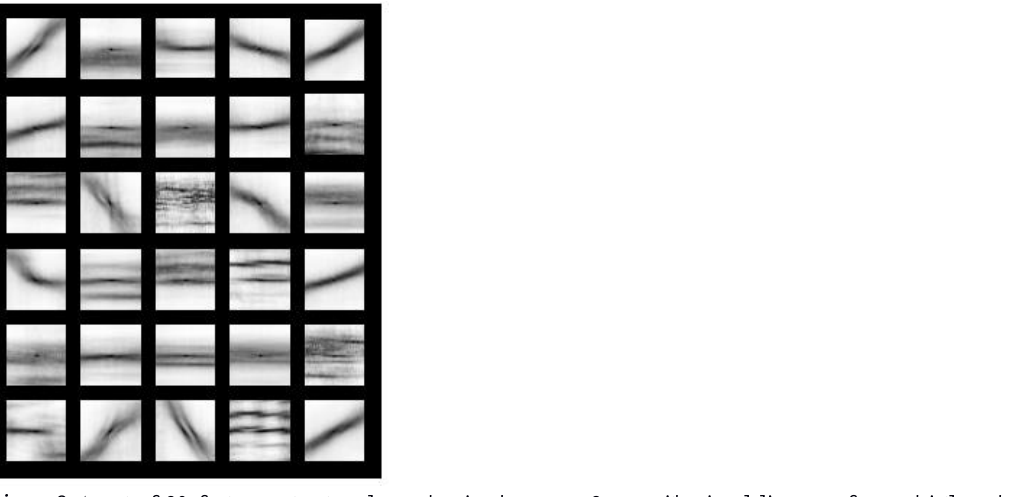
Figure 9. A set of 30 feature extractors learned using k-means. Ones with signal lines are from whistles whereas ones